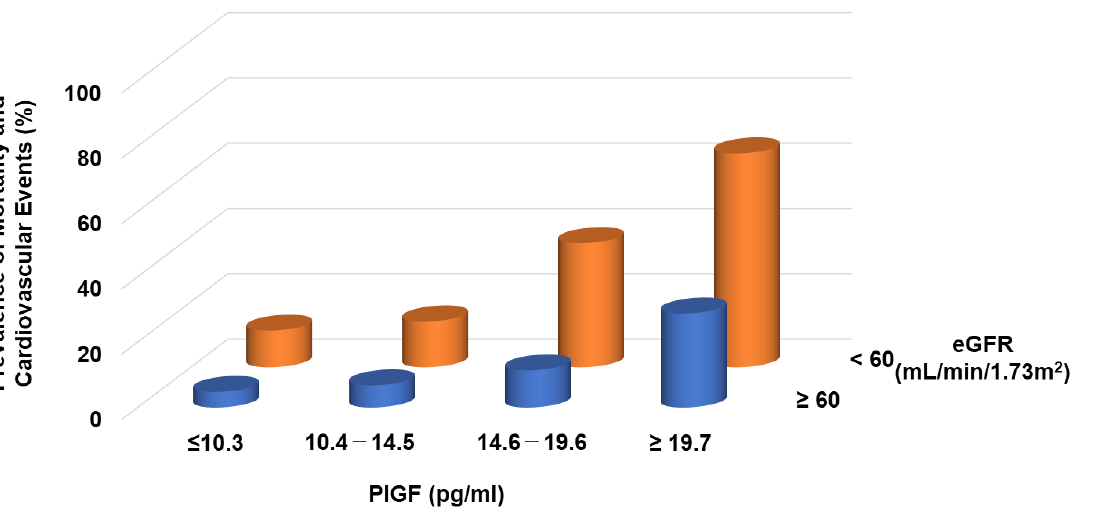
Figure 2. Prevalence of mortality and cardiovascular events in CKD patients. Higher PlGF levels are significantly associated with adverse events.